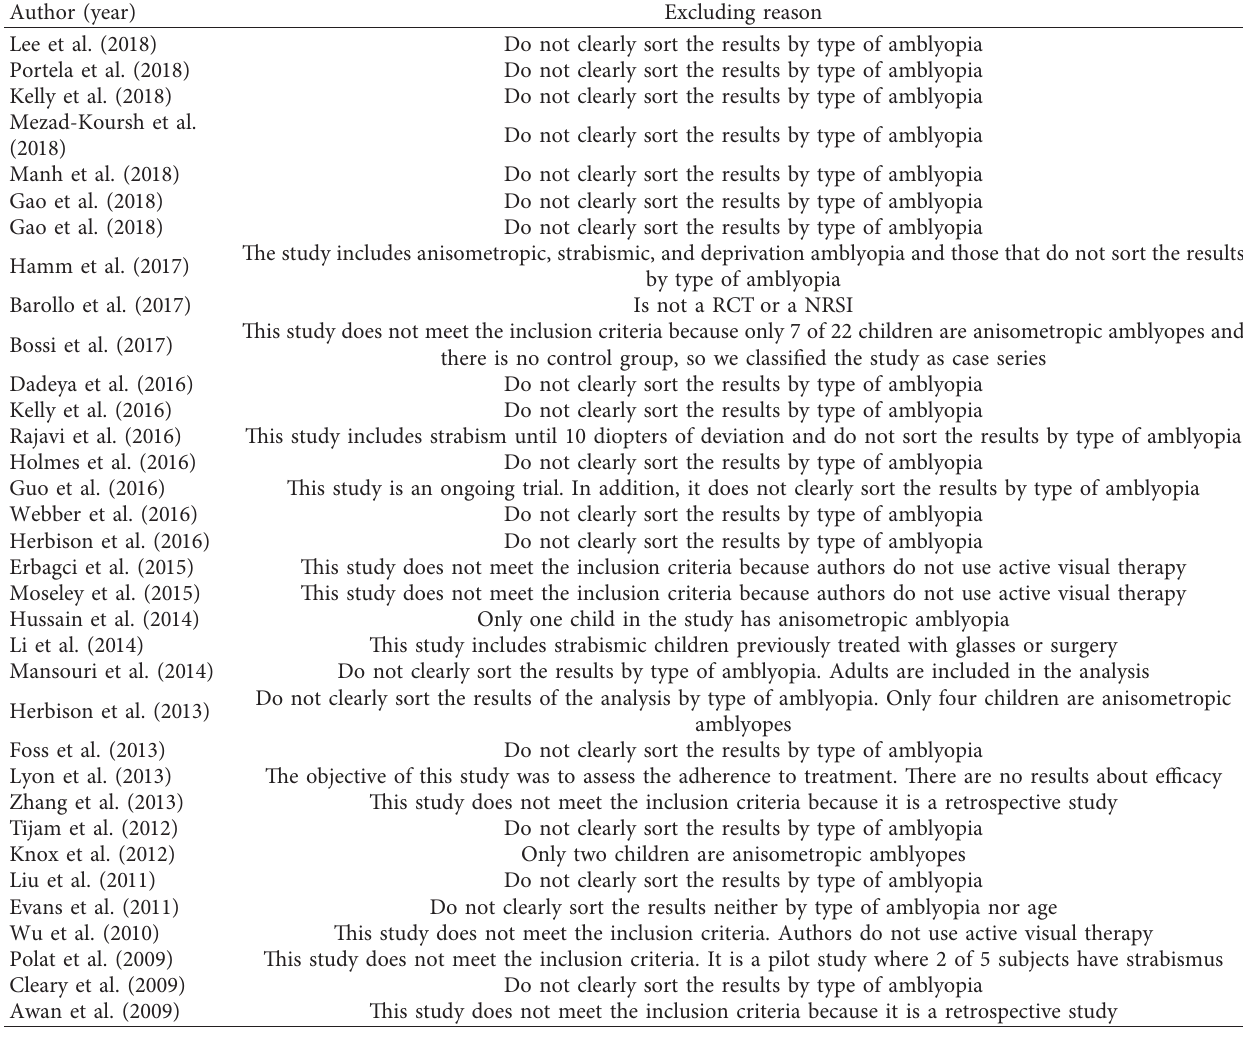
Table 5: Excluded articles in the systematic